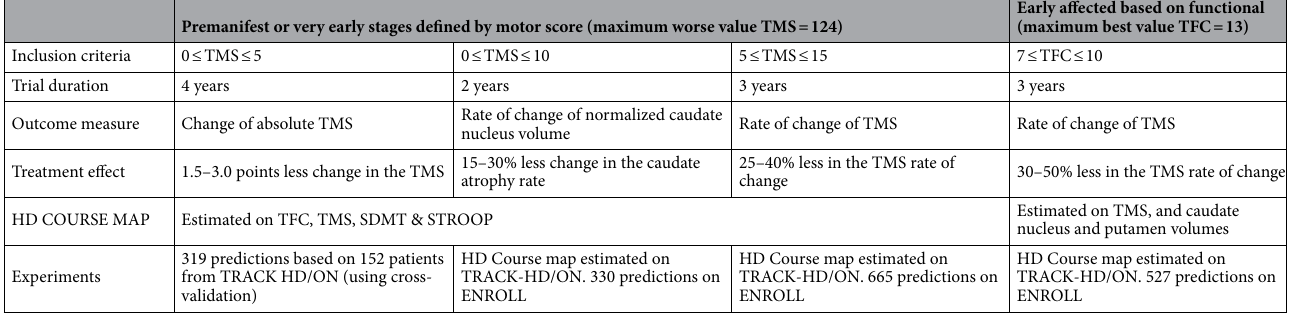
Table 2. Trial designs to compare selection procedures and sample sizes (Fig. 6). Simulations target different disease stages, trial durations and outcome measures. Three designs aim to reproduce the ones of the Crest-HD, Pride-HD and 2Care-HD trials 24–26